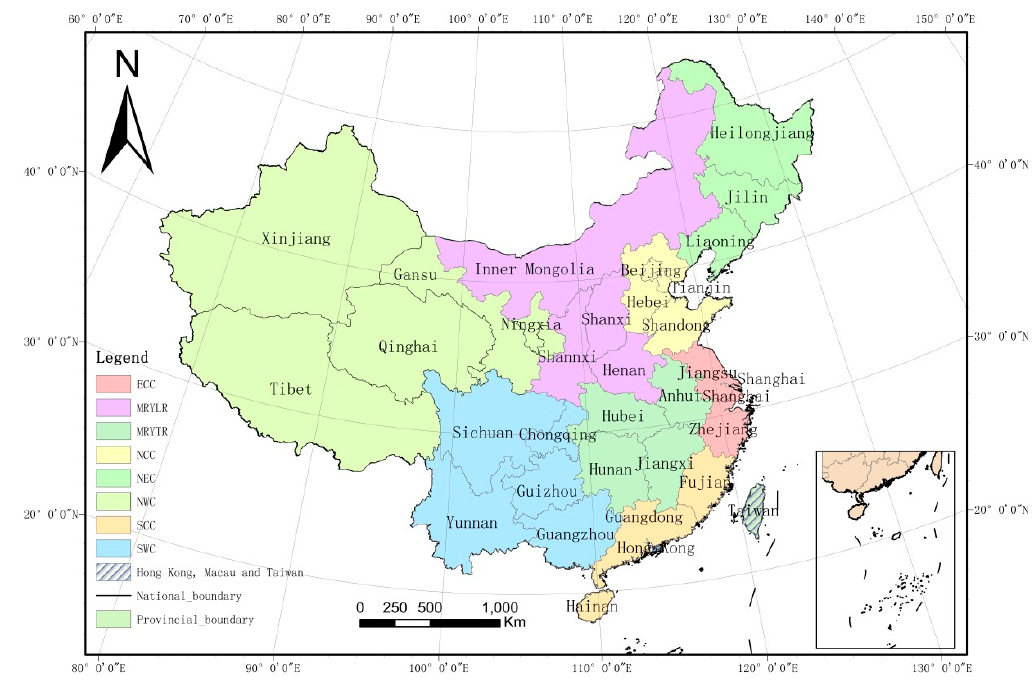
Figure 1. China—the location of the study area and its provincial divisions: Northeast China (NEC), Northern Coastal China (NCC), Eastern Coastal China (ECC), Southern Coastal China (SCC), the Middle Reaches of the Yellow River (MRYLR), the Middle Reaches of the Yangtze River (MRYTR), Southwest China (SWC), and Northwest China (NWC).